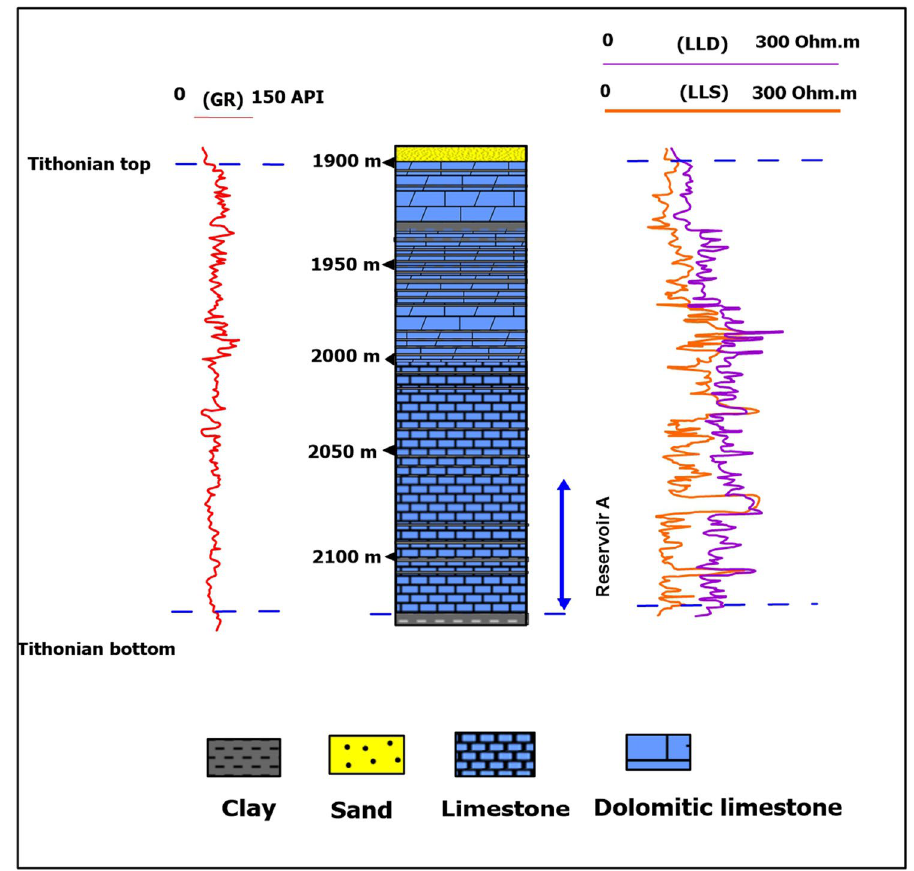
Fig. 6 Characterization of the Tithonian series using well logs (W1